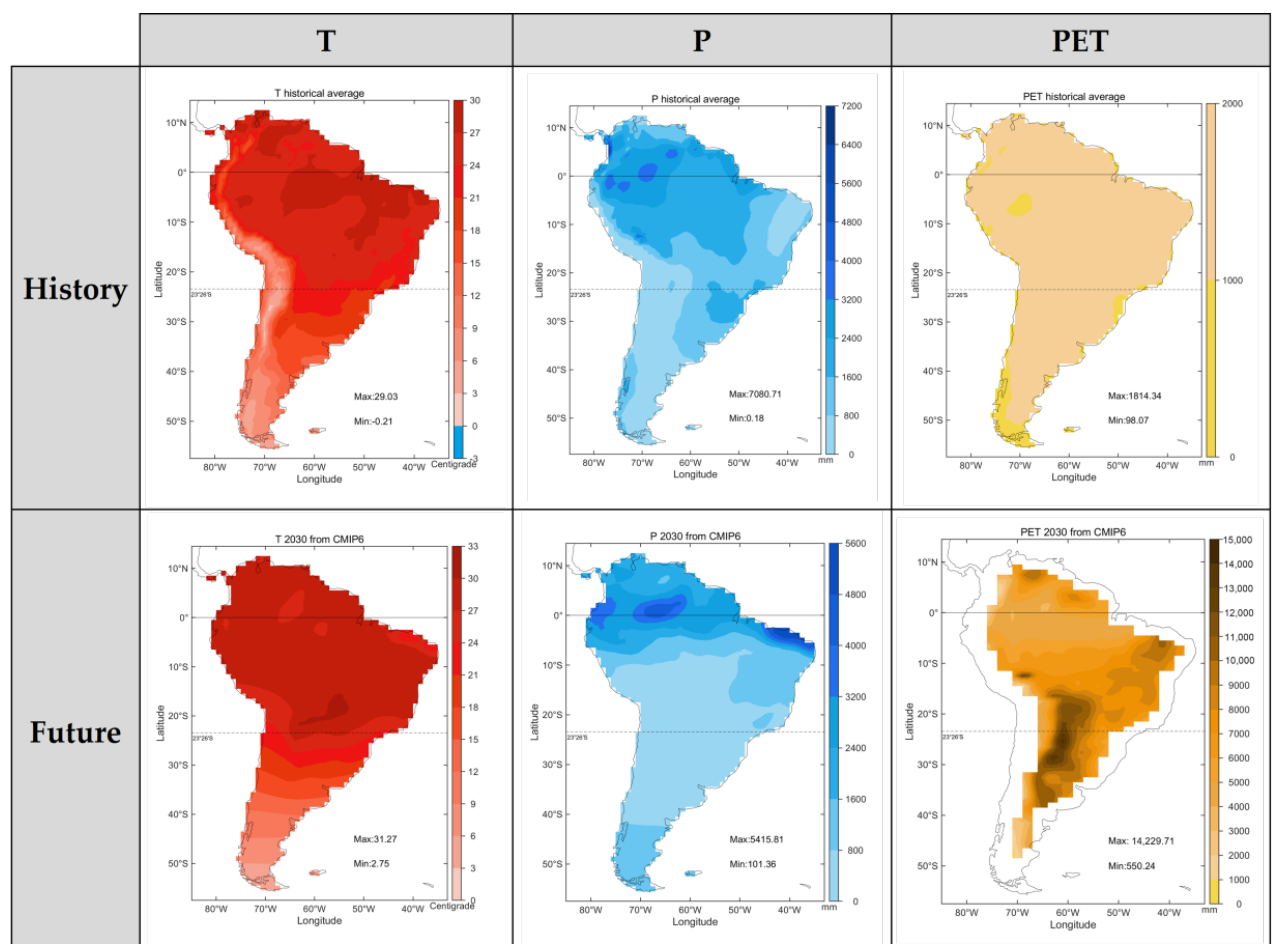
Figure 11. The map of historical multi-year average value from CRU and the prediction value in 2030 from CMIP6 about T, P and